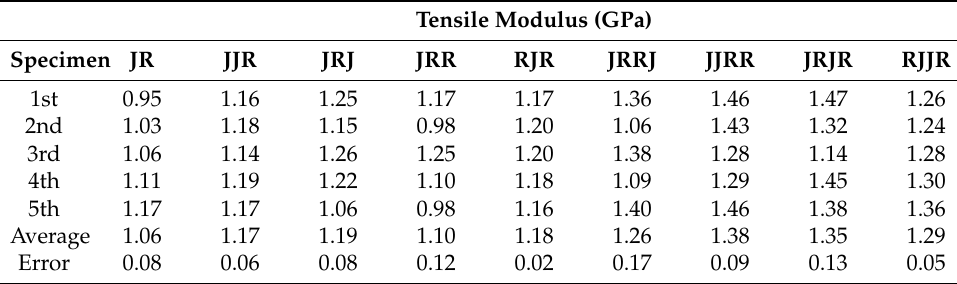
Tensile Modulus (GPa)